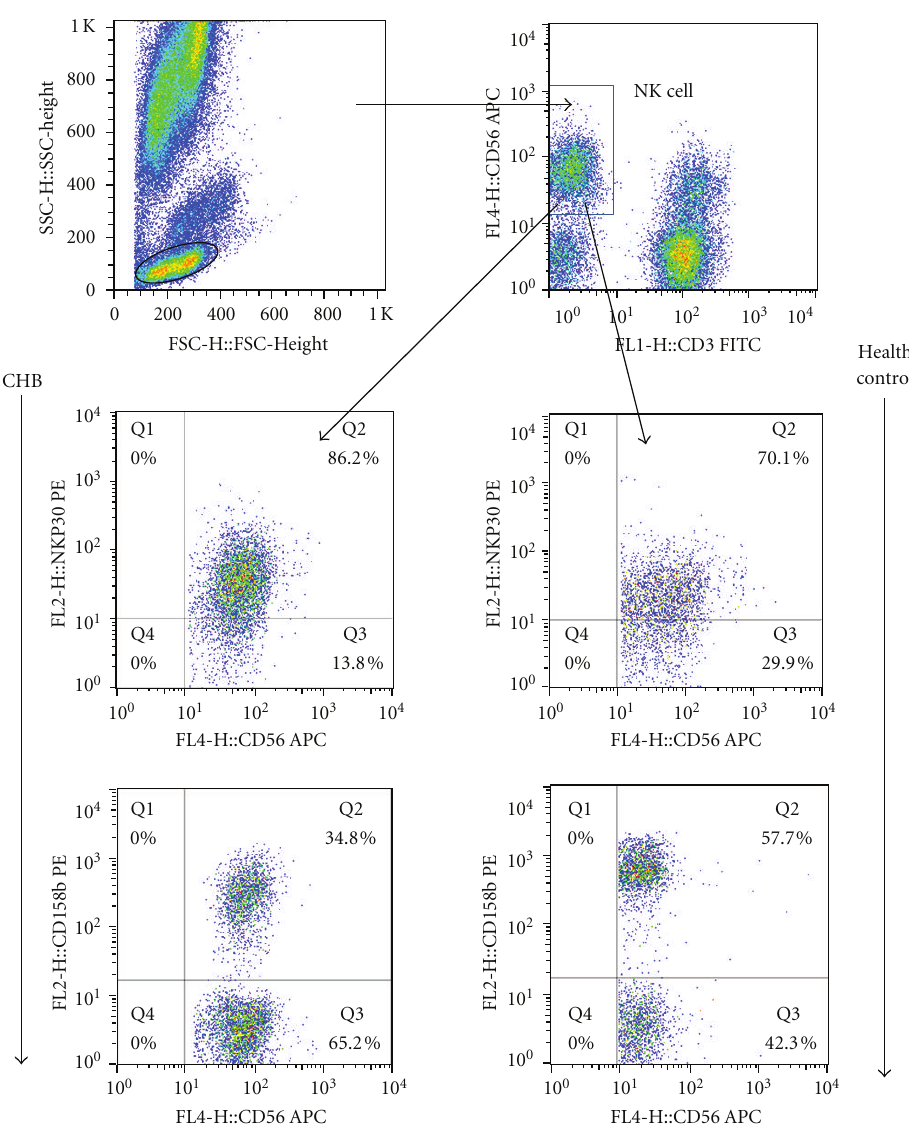
Figure 1: Characterization of di ff erent subsets of NK cells. The frequency of di ff erent subsets of NK cells was determined by flow cytometry analysis using specific antibodies. Briefly, peripheral blood mononuclear cells were prepared from individual subjects and stained with a cocktail of APC-anti-CD56 and FITC-anti-CD3 and the cells were gated on CD3 − CD56 + as NK cells. Furthermore, the cells were stained with APC-anti-CD56 and PE-conjugated antibodies against CD158a, or CD158b, NKp30, NKp44, NKp46, NKB1, KIR2DL3, NKG2D, NKG2A, NKG2C, or isotope controls, respectively, for characterizing the frequency of di ff erent subsets of NK cells. Data shown are representative charts of flow cytometry analysis of some subsets of NK